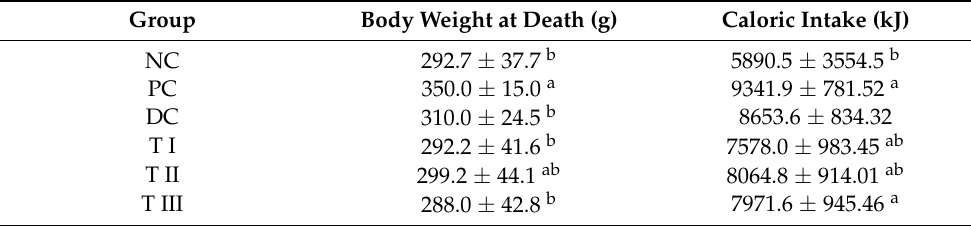
Table 1. Anti-obesity effect of E.tapos shell extract on body weight and caloric intake. Group Body Weight at Death